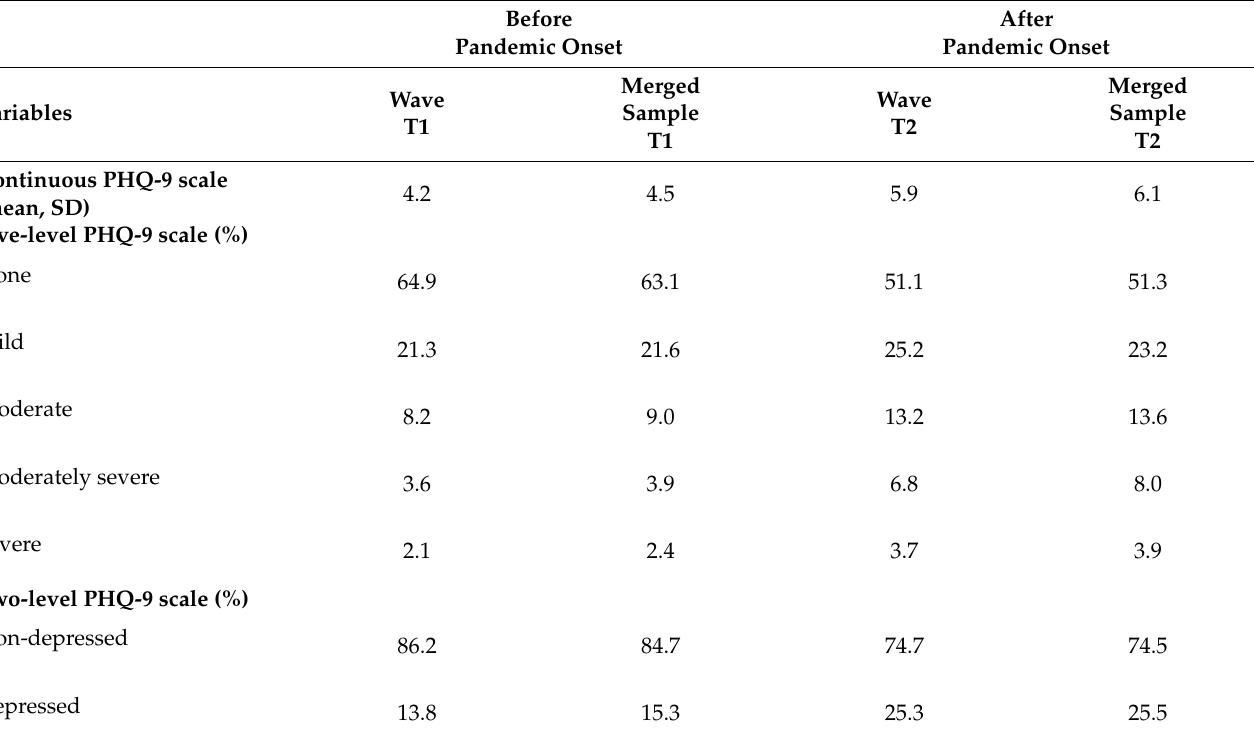
Table 2. Descriptive statistics of mental health outcomes and gender across study